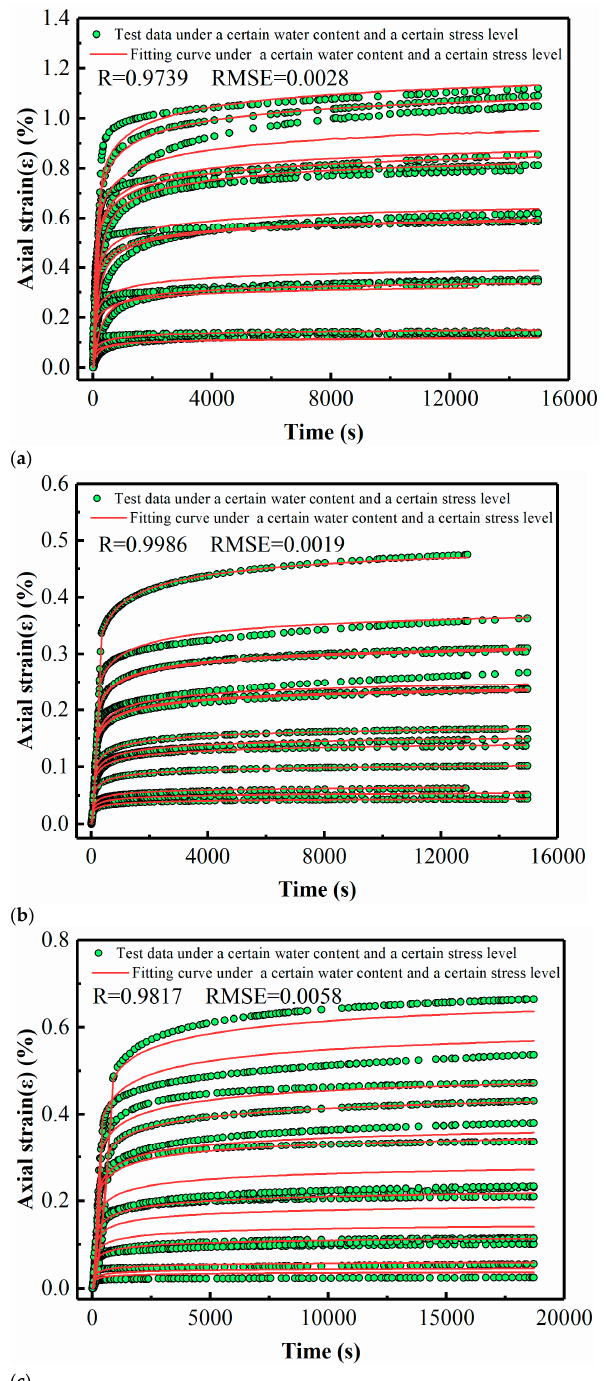
Figure 9. Fitting results of the MEC model under multi-moisture levels. ( a ) Soft soil (including 15 sets of test data, D = 0.214, 0.427, 0.646, 0.834 and 0.945 when the water content is 21%, D = 0.195, 0.391, 0.587, 0.754 and 0.950 when the water content is 18%, and D = 0.172, 0.345, 0.552, 0.759 and 0.966 when the water content is 15%). ( b ) Lime soil (including 14 sets of test data, D = 0.184, 0.368, 0.551, 0.735 and 0.919 when the water content is 21%, D = 0.160, 0.346, 0.532 and 0.665 when the water content is 18%, and D = 0.184, 0.368, 0.551, 0.735, 0.919 when the water content is 15%). ( c ) RHA–lime soil (including 14 sets of test data, D = 0.184, 0.368, 0.551, 0.735 and 0.919 when the water content is 21%, D = 0.195, 0.391, 0.587, 0.754 and 0.950 when the water content is 18%, and D = 0.172, 0.345, 0.552, 0.759 and 0.966 when the water content is